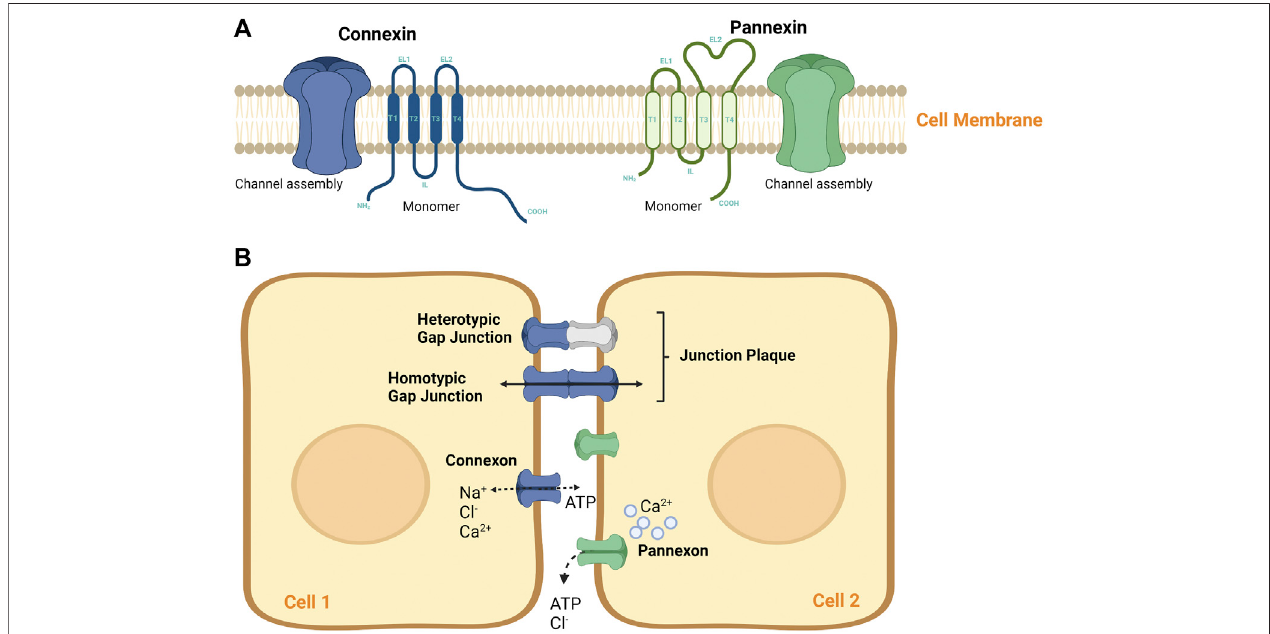
FIGURE1| Connexinandpannexinmolecularstructure. (A) AschematicdiagramofConnexinandPannexinproteinstructure.Bothproteinchannelssharesimilar topology by having four α -helical transmembrane (T) domains, two extracellular loops (EL), and one intracellular loop (IL), with their amino (NT) and carboxyl termini exposed to the cytoplasm. Both, Cxs and Panxs are shown to oligomerize into a hexamer to form single membrane channels at the cell surface, namely (B) A representation of Connexons and Pannexons in cellular communication. Connexons may mediate autocrine signaling as independent hemichannels or may form junctional plaque (or gap junction) via the docking of two connexons of adjacent cells. Connexons can be of homomeric hemichannels (single Cx isoform) or heterotypic hemichannels (multiple Cx isoforms), that can interact with each other in different ways to mediate intercellular communication. Pannexons are known to mediate paracrine signaling. These channels tend to mediate paracrine signaling, however, they do not form GJ plaque.